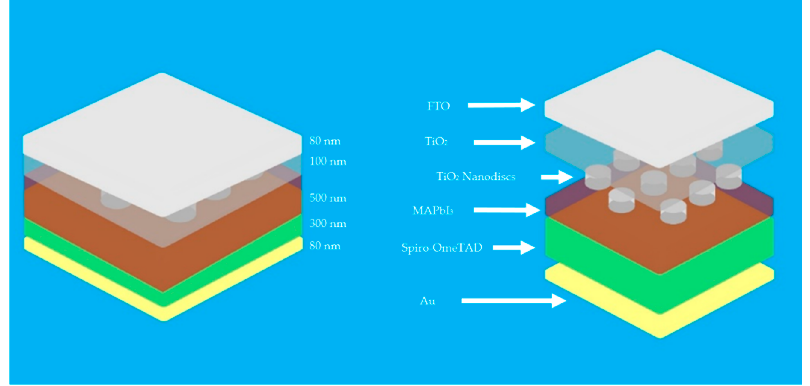
Figure 1. Simulated structures of PSC with photonic crystals on FDTD simulations.